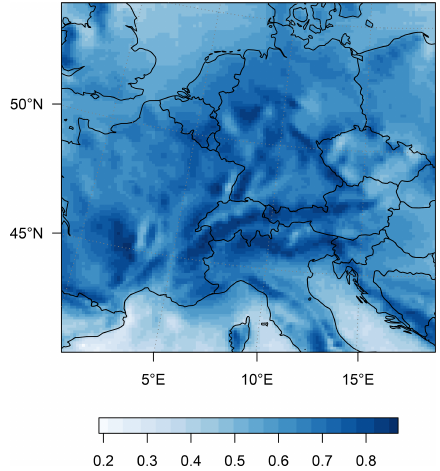
Figure B2. Training 1955–2020: proportion of variance explained ( R 2 ) for each grid cell for the precipitation